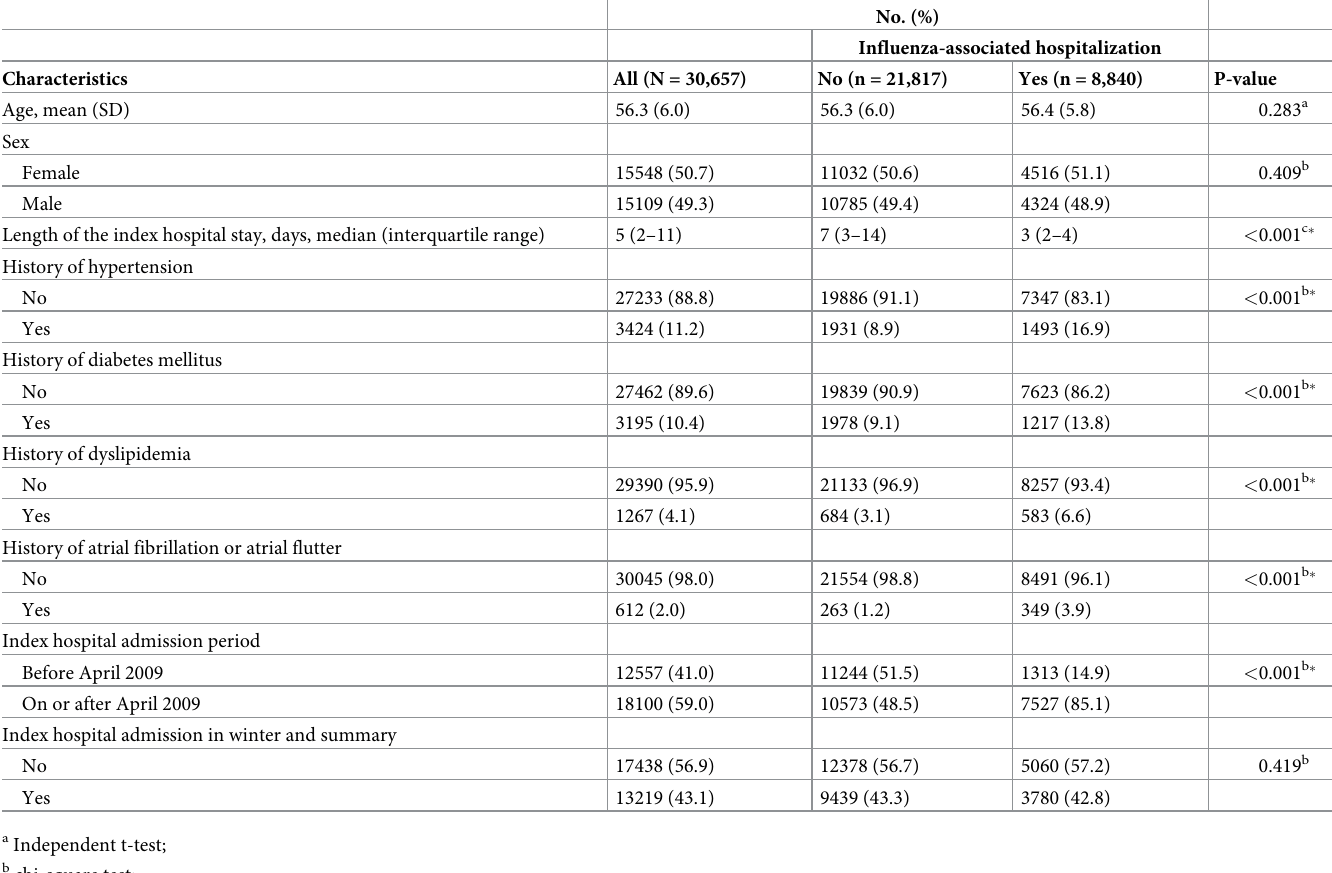
Table 1. Characteristics of the study population (N =